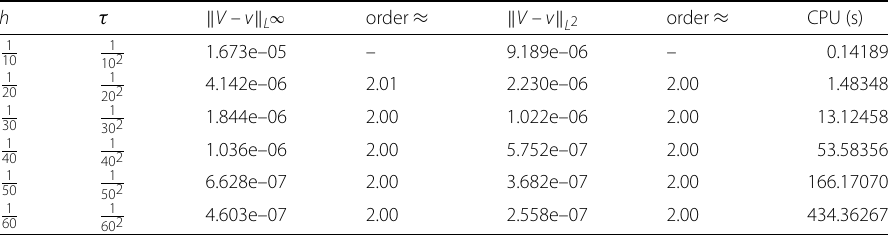
Table 9 Errors and computational orders of compact difference scheme with β = 1 h